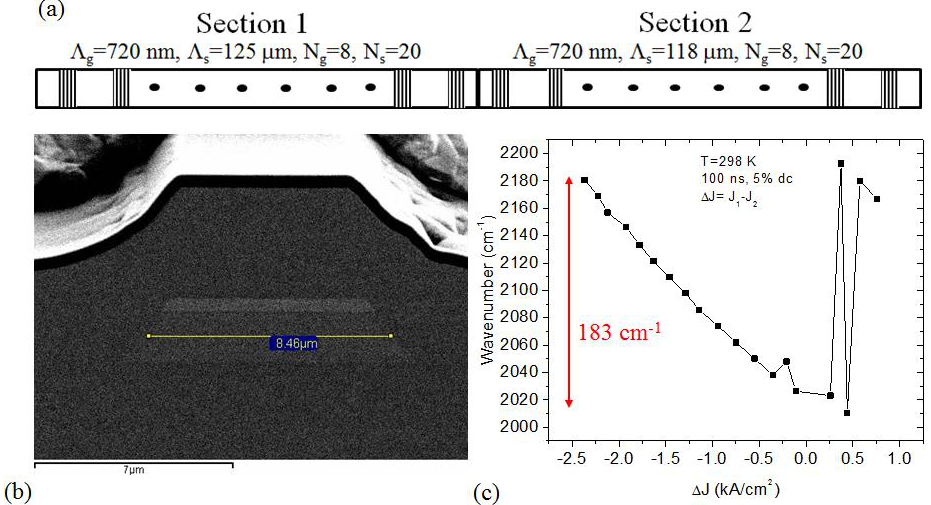
Figure 3 . ( a ) Top view schematic of two section laser with sampled grating design specifics. Λ g = grating period. Λ s = sampling period ( b ) SEM cross-section of a buried ridge SGDFB